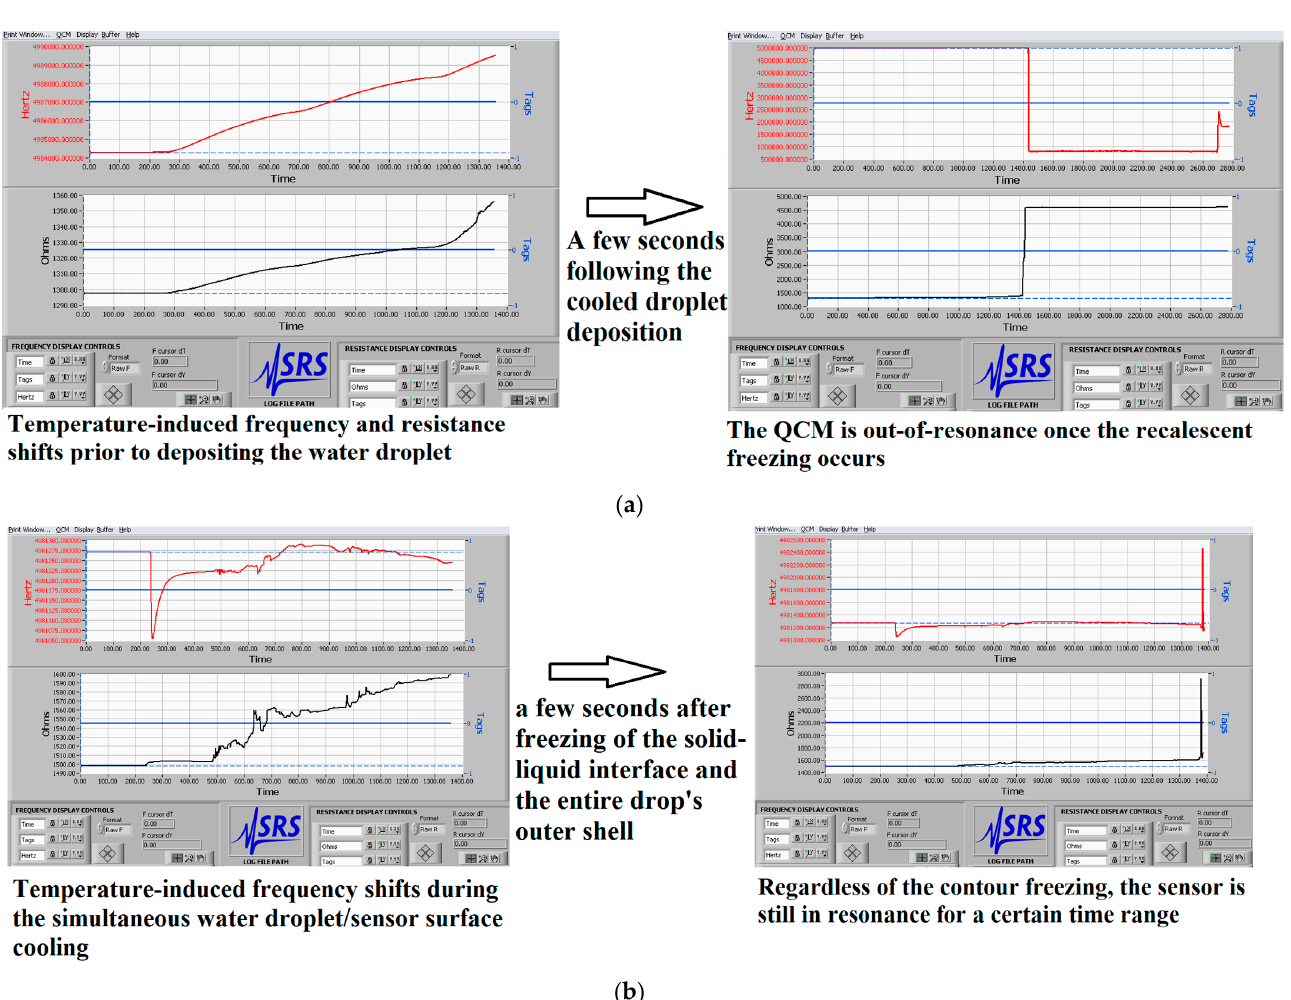
Figure 5. Real-time sensor response of two 5 MHz soot coated QCMs immediately prior to (left side) and after the initial solidification (right side) of a 50 μ L water droplet placed in the middle of the sensing surface during ( a ) bulk and ( b ) contour freezing. The graphs are directly snapped from the PC’s screen instead of being processed by a specific software (e.g., OriginLab) with an aim of proving the authenticity of our experiments.